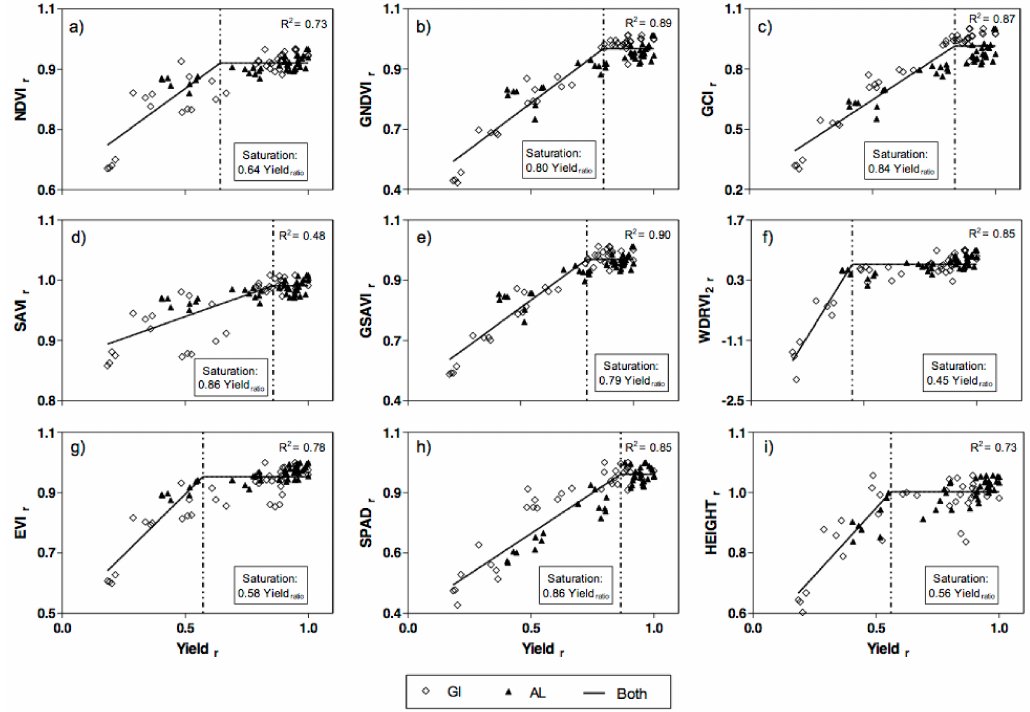
Figure 5. Response of ( a ) NDVI, ( b ) GNDVI, ( c ) GCI, ( d ) SAVI, ( e ) GSAVI, ( f ) WDRVI 2 , ( g ) EVI vegetation indices at V12 stage, ( h ) SPAD and ( i ) plant height (PltH) at VT stage to yield achieved at harvest in the experiments. Saturation N dose was determined when there was no response to higher N fertilization. The results of Almacelles (AL) and Gimenells (GI) are presented as ratios dividing the indices values by the maximum observed in each year. ‘Both’ indicates that the two fields were analyzed